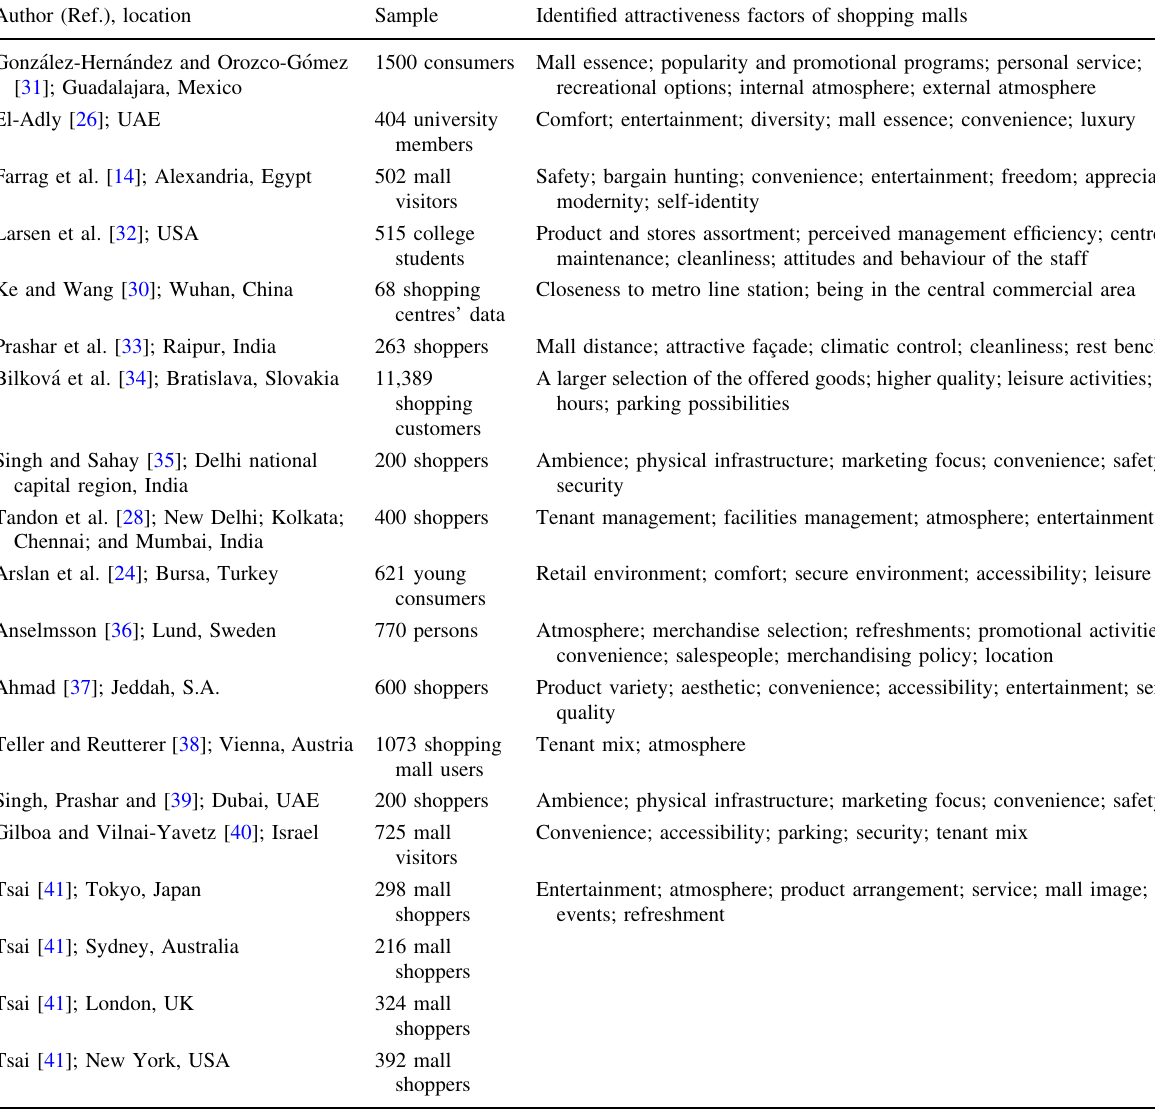
Table 2 Studies in different cities on attractiveness factors of shopping malls Author (Ref.), location